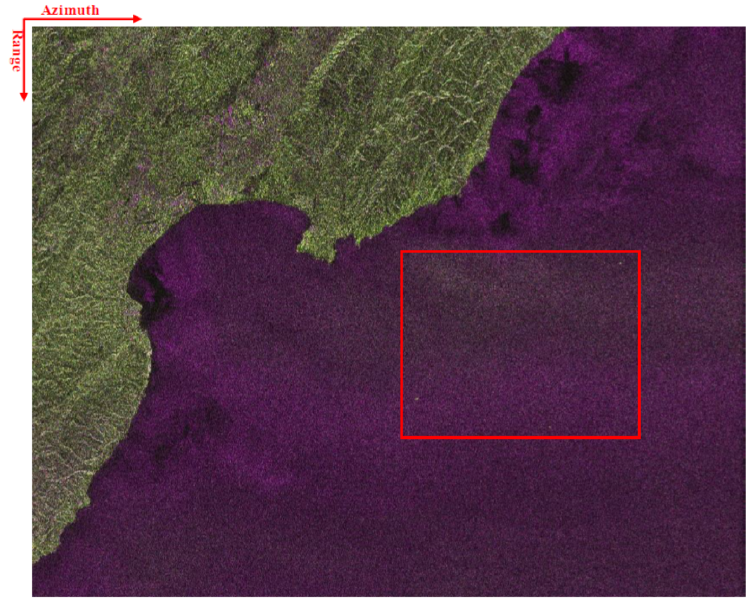
Figure 7. Data set 2: ( a ) PDF of normalized reflection symmetry and the fitted statistical distributions; ( b ) curve shows the relationship between false alarm rate and threshold; ( c ) GEV-based CFAR detection result on the reflection symmetry; ( d ) CFAR detection result on the VH image.